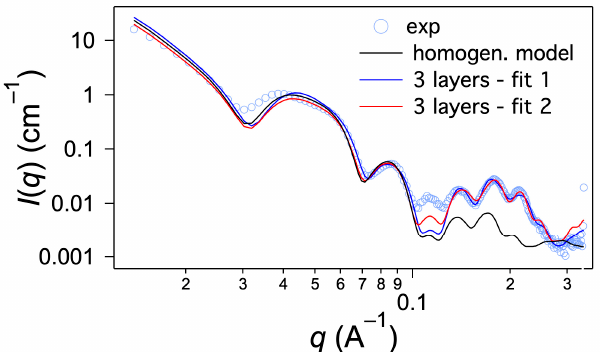
Figure 7. Intensity scattered by HUB-4 (2 wt.% in C 6 H 12 ) and fits with the models of homogeneous tube and with the three-layer model. The parameters of the fits 1 and 2 are given in Table 1.